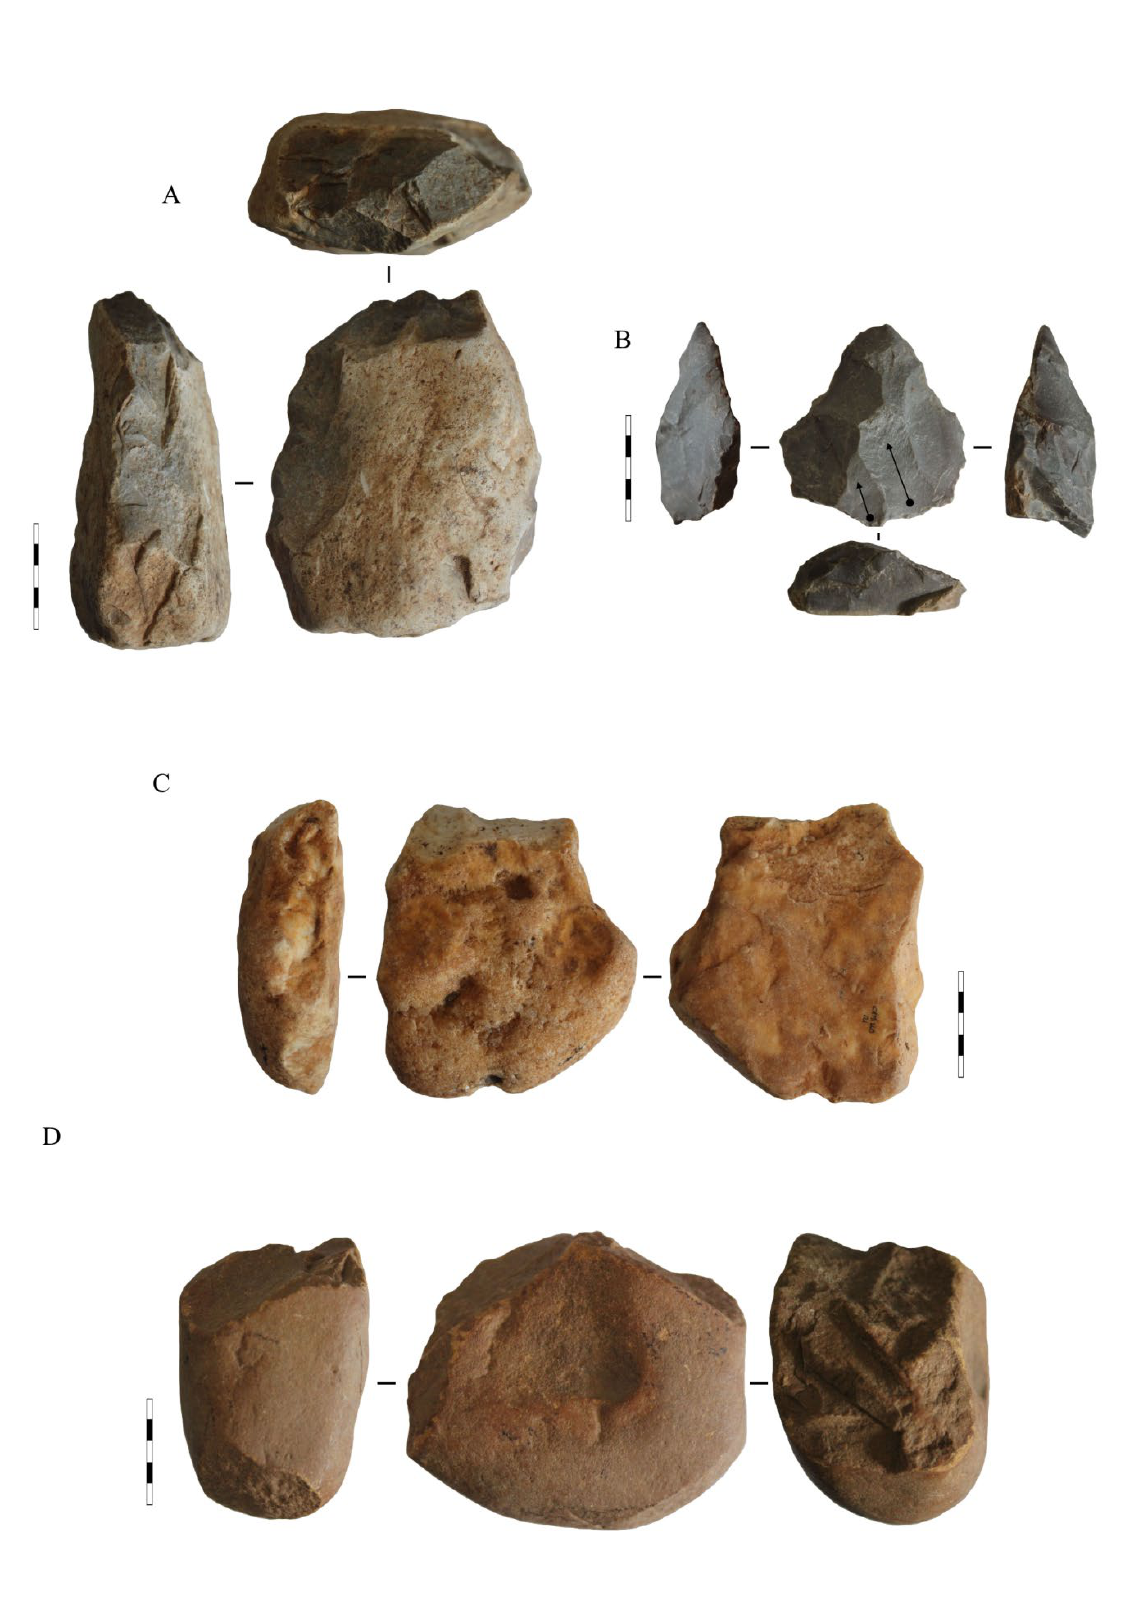
Figure 13. Large Cutting Tools of Camillo. A: Uniface. B: Pick in quartzite. C and D: Choppers. Scale bar: 5